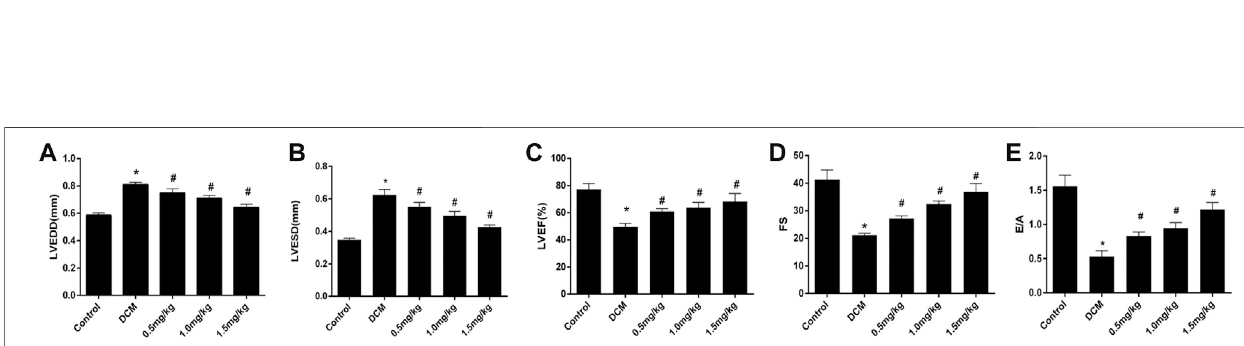
Frontiers in Pharmacology |